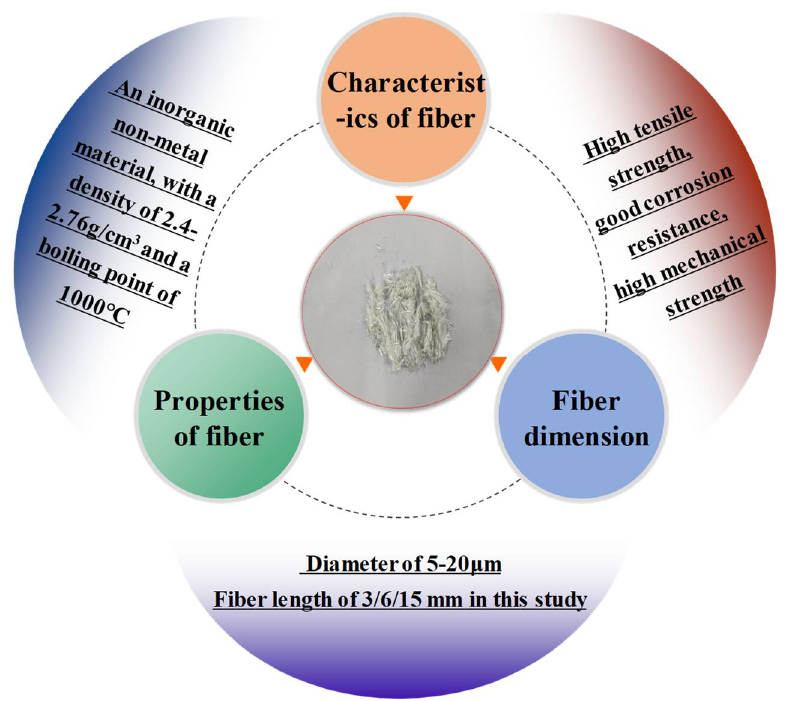
Figure 1. Characterization of glass fibers. Table 1. The basic parameters of glass fiber.